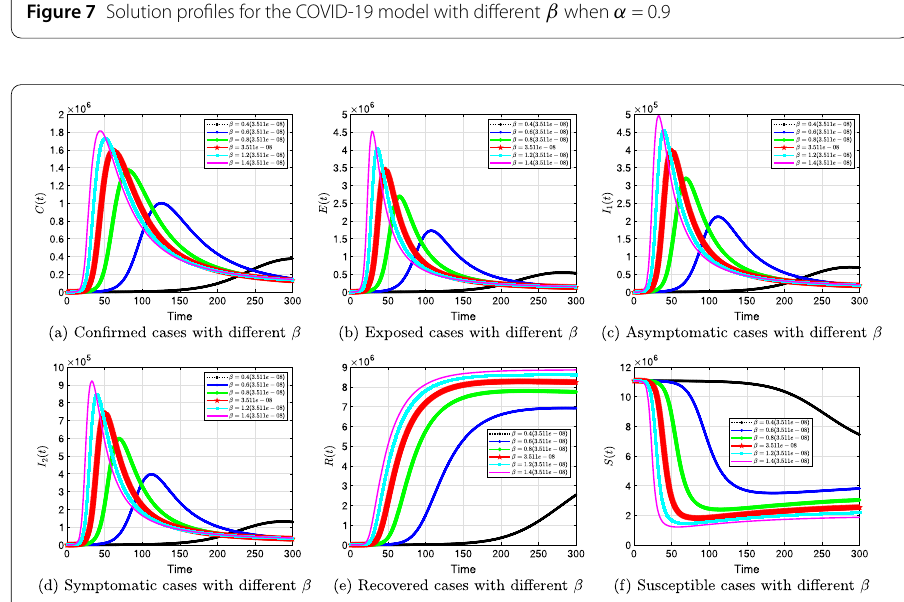
Figure 8 Solution profiles for the COVID-19 model with different β when α =